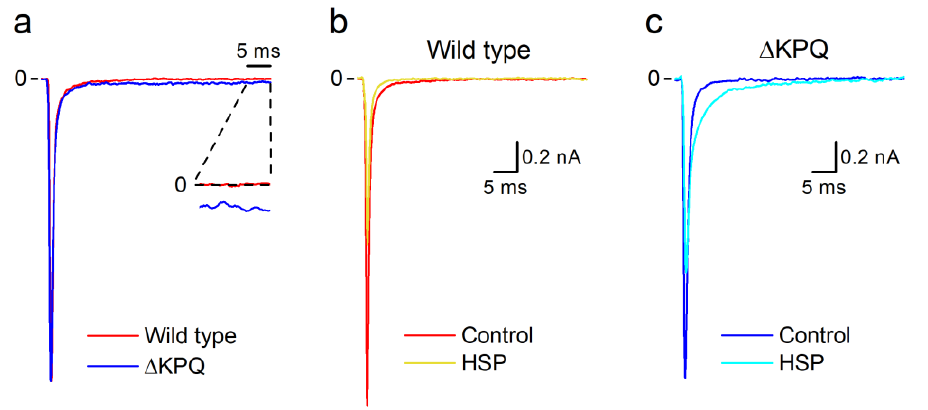
Figure 1. Comparison of human WT and LQT3 Na V 1.5 currents. ( a ) Representative I Na traces recorded in HEK293T cells expressing WT hNa V 1.5 channels or the hNa V 1.5 LQT3 variant ∆ KPQ. Each trace was normalized with respect to peak inward current. The inset shows the last 5-ms interval of the current traces amplified (10 × ). Note that the ∆ KPQ LQT3 variant presents a larger amplitude of I Na-Late compared to WT. ( b , c ) Comparison of the e ff ects of 100 µ M HSP on WT ( b ) and ∆ KPQ ( c ) Na V 1.5 currents. Currents were evoked with 50-ms voltage-clamp pulses to − 20 mV from a holding potential of − 100 mV. Pulse rate 0.25 Hz.